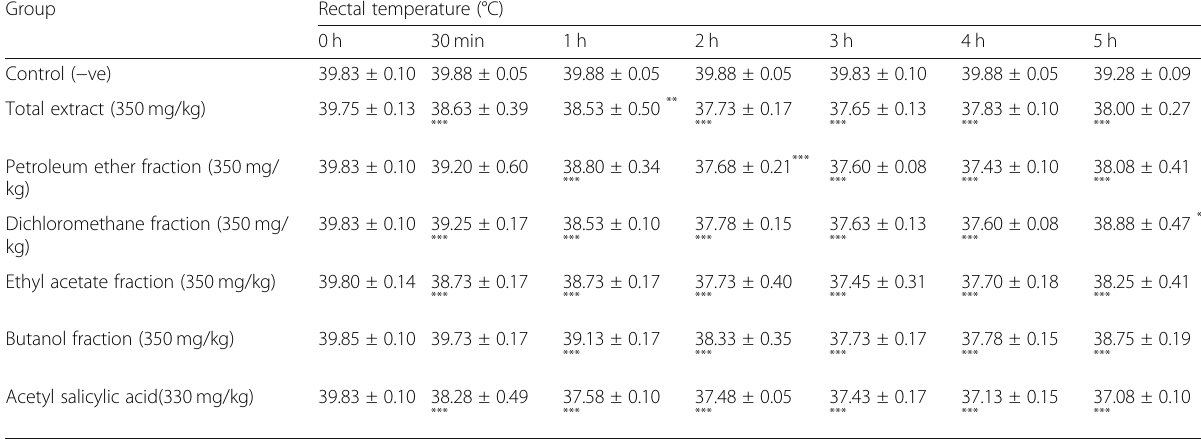
Table 9 Results of the anti-pyretic activity of the total ethanol extract and the different fractions of C. myxa L. leaves using yeast- induced pyrexia method